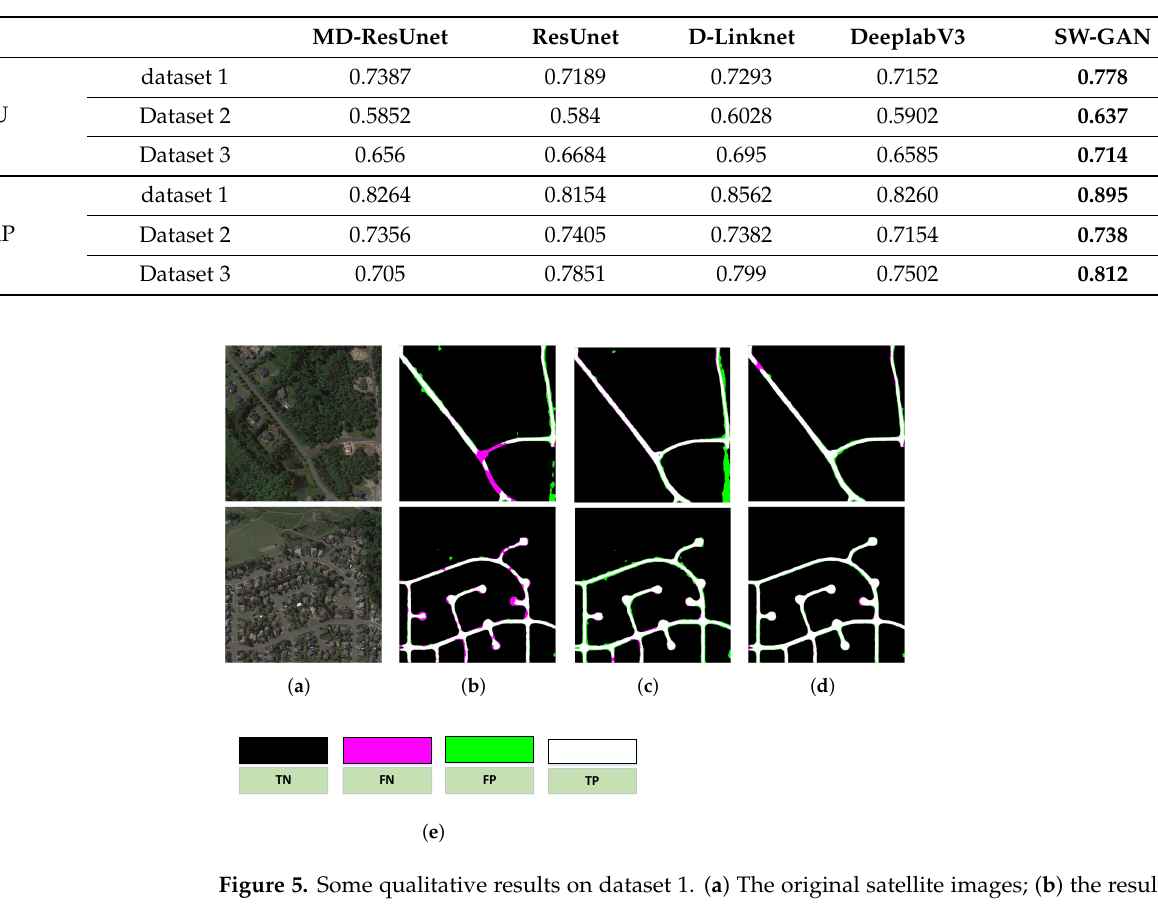
Table 2. SW-GAN Performance Evaluation (bold: best).